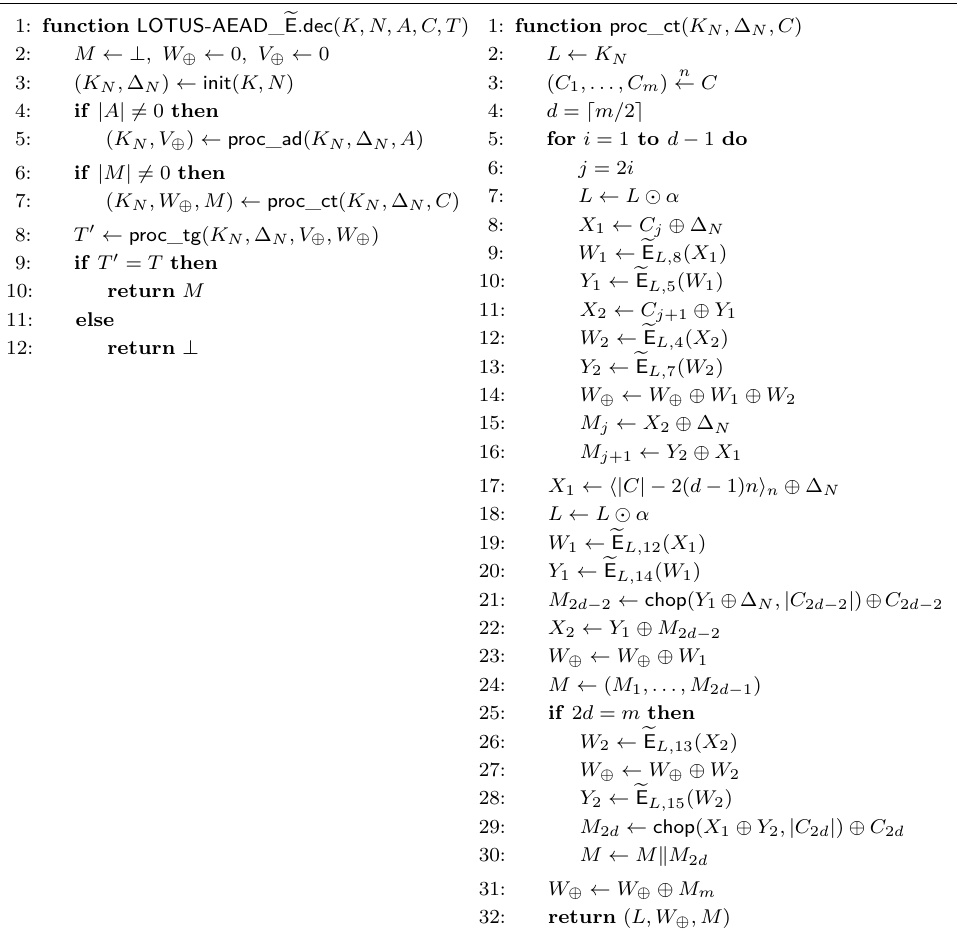
Algorithm 6 The verified decryption algorithm of LOTUS